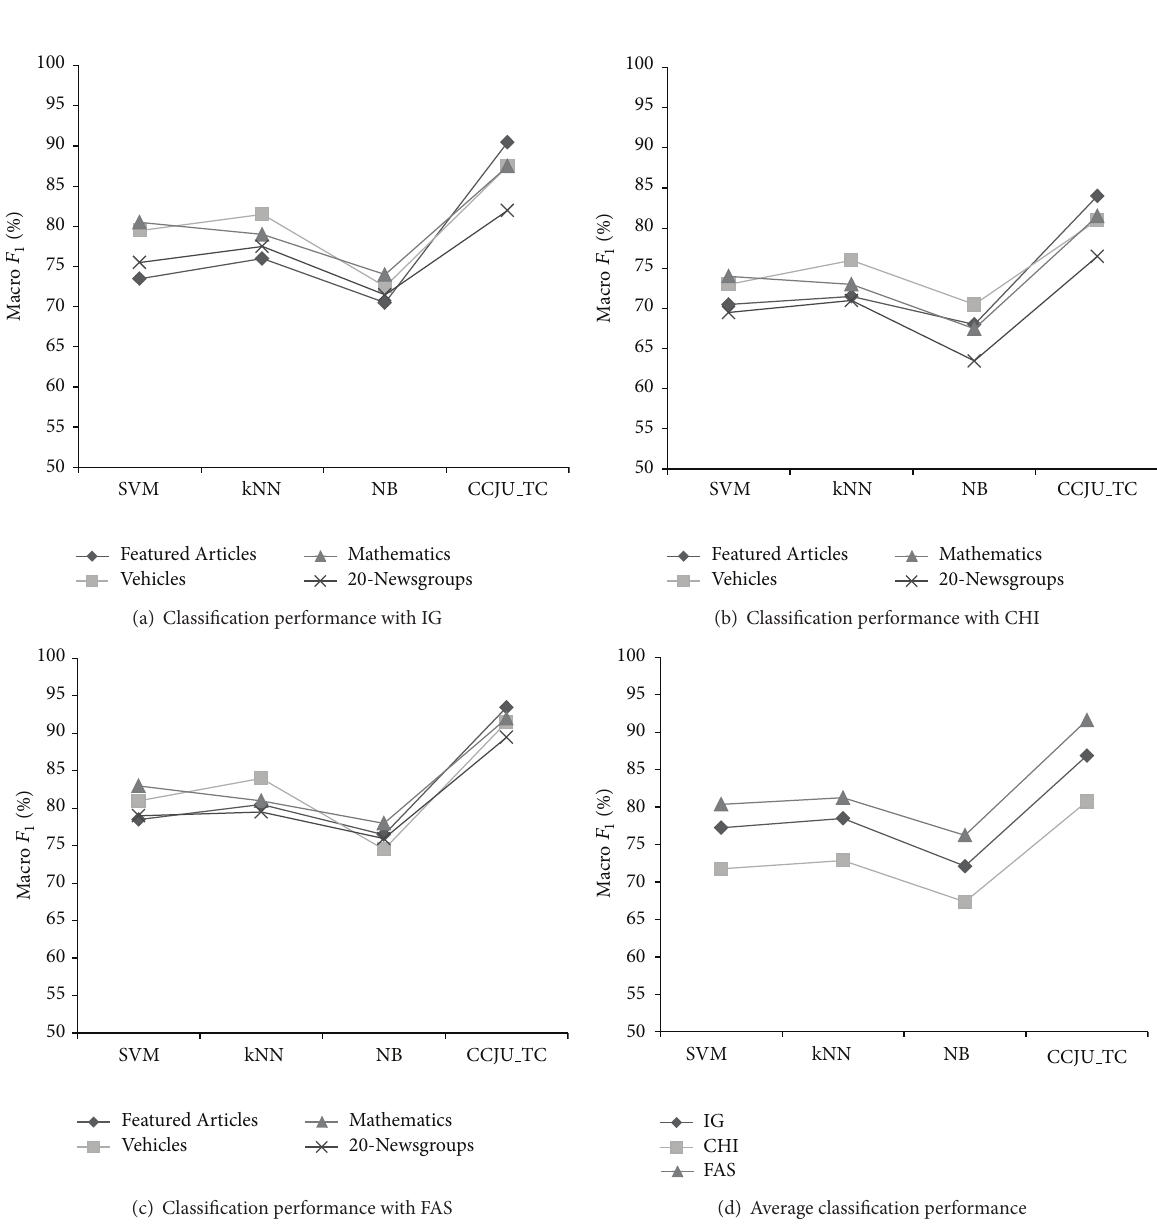
Figure 5: Classification results